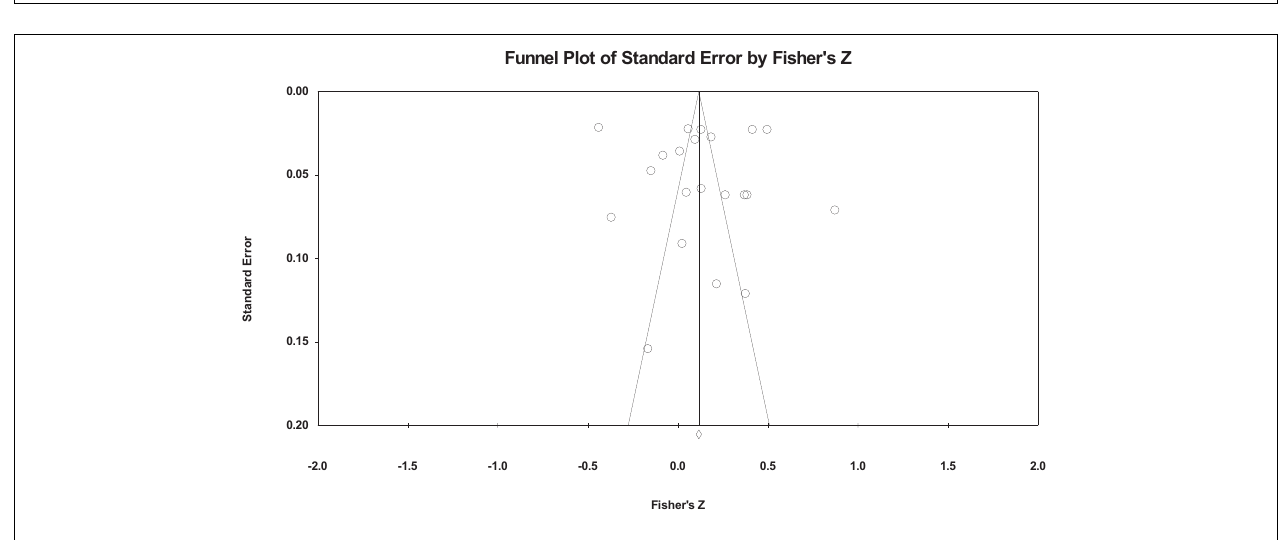
FIGURE 2 | Funnel plot of workaholism on the work performance.